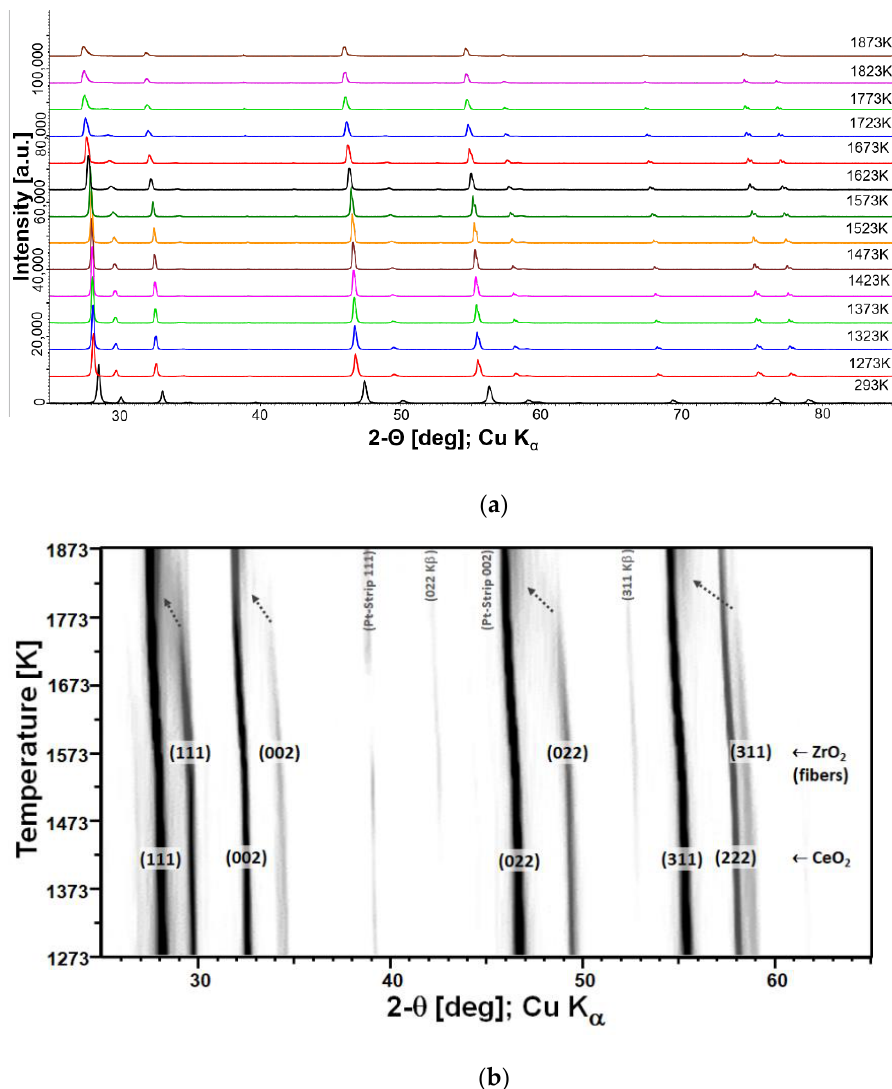
Figure 6. ( a ) Stacked XRD-profiles of the CeO 2 /YSZ felt mixture at temperatures between 293 K and 1873 K. ( b ) ‘Plane view’ (2D) XRD-profile. The arrows illustrate the shift of the peaks of